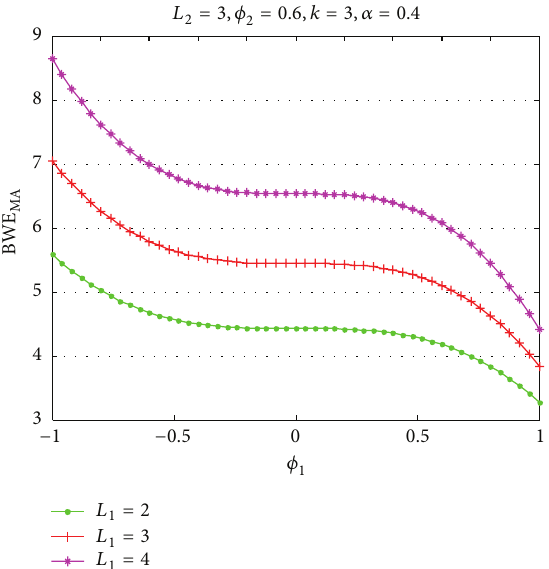
Figure 9: Impact of 𝜙 1 on bullwhip effect for different 𝐿 1 under the MA.